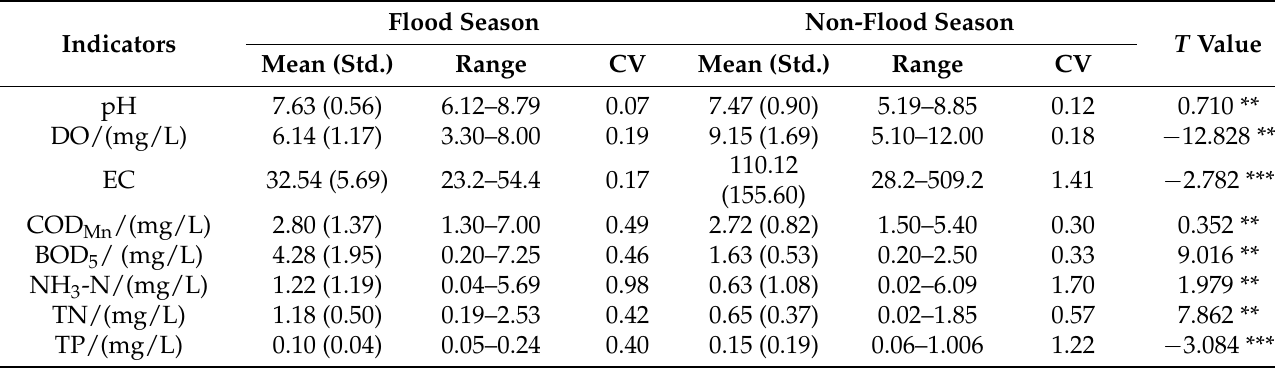
Table 6. Scores and weights of water quality factors in WQI